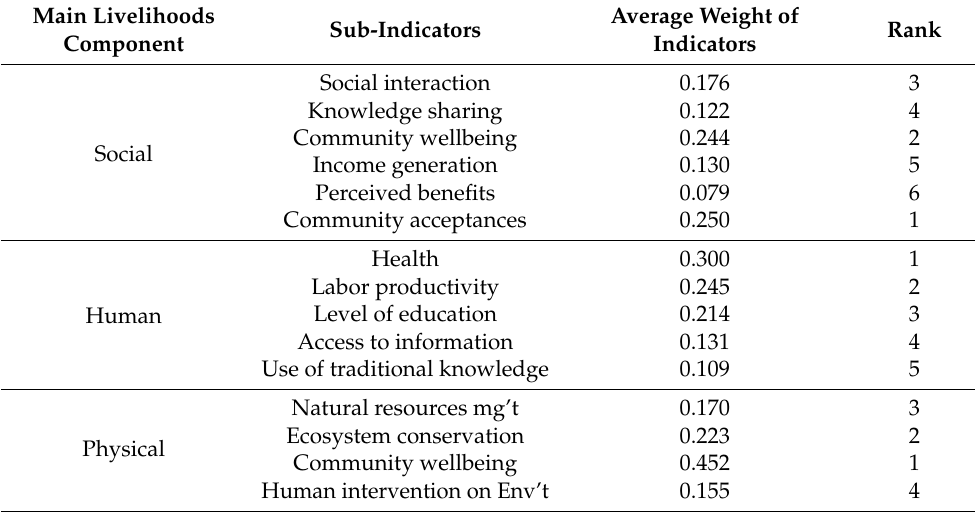
Table 5. Community-based livelihood indicators weight and rank in relation to LWEF nexus. Main